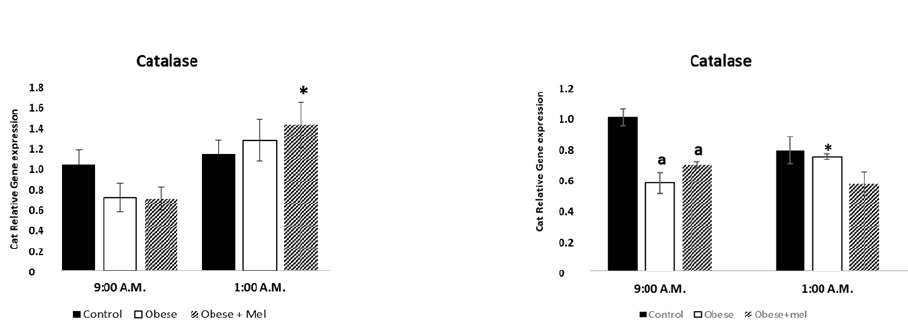
Figure 4. Relative gene expression of Catalase enzyme in subcutaneous ( A ) and perirenal ( B ) adipose tissue of male Wistar rats at two different times (9:00 a.m. and 1:00 a.m.). Each value represents the mean and s.e.m. (n = 5). The letter indicates significant differences between diets (control or high fat diet) at the same schedule ( a p < 0.05 vs. control) and the asterisk (* p < 0.05) indicates significant differences between schedules in each experimental group.